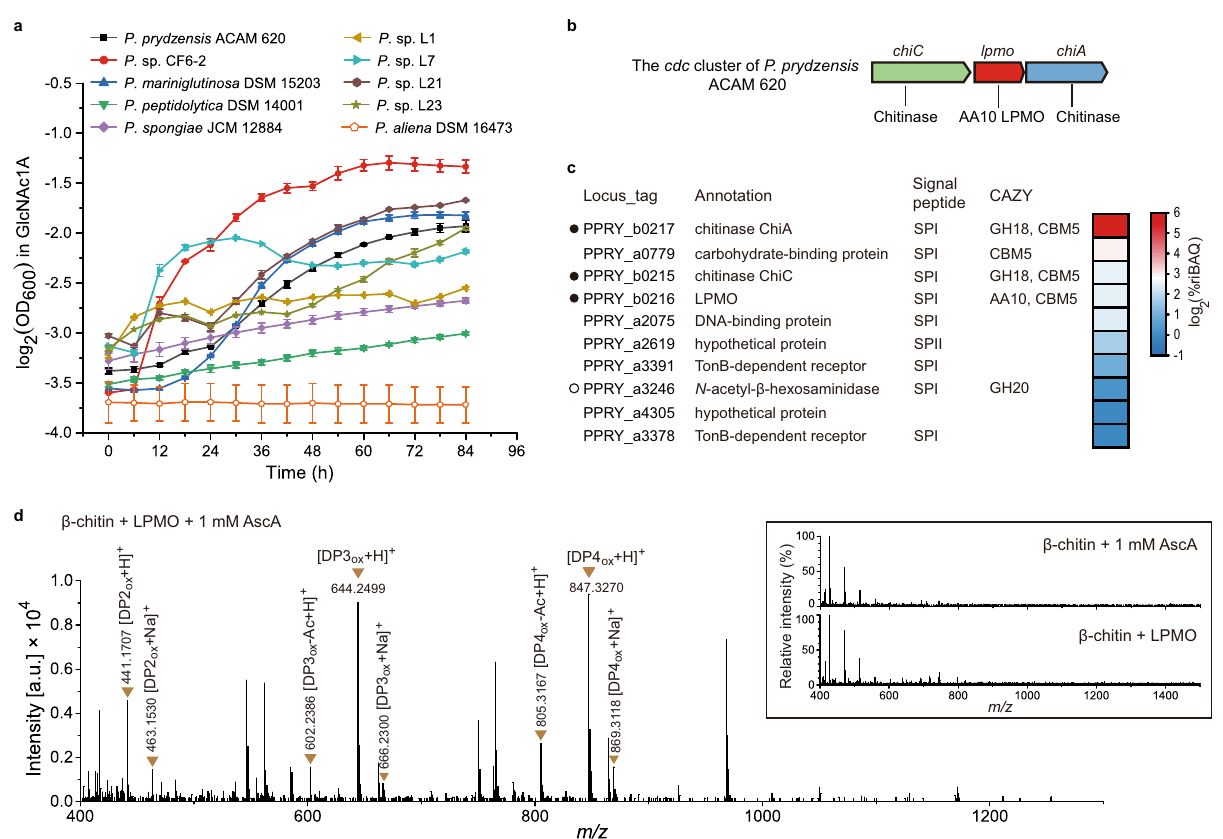
Fig. 2 | Growth of chitinolytic marine Pseudoalteromonas strains on GlcNAc1A and functional analysis of the recombinant AA10 LPMO from P. prydzensis ACAM 620. a Growth of chitinolytic Pseudoalteromonas spp. in the minimal med- ium supplemented with 0.2% (w/v) GlcNAc1A. The y -axis represents log 2 transfor- mation of the OD 600 value. Data are presented asmean ± standard deviations (SD) ( n =2 independent experiments). b Genetic organization of the cdc cluster of P. prydzensis ACAM 620. c Heat map for the top ten most abundant proteins in the secretome of strain ACAM 620 grown on 0.5% (w/v) colloidal chitin as the sole carbon source. The colors in the heat map indicate relative protein abundance, ranging from high (red) to low abundance (blue). The data are presented as log 2 transformation of the mean values of two biological replicates for each protein. These ten proteins account for 83.86% of the total protein abundance. The locus tag, protein annotation, type of signal peptides and CAZy family (glycosyl hydro- lase (GH), carbohydrate-binding module (CBM) and auxiliary activity (AA)) are